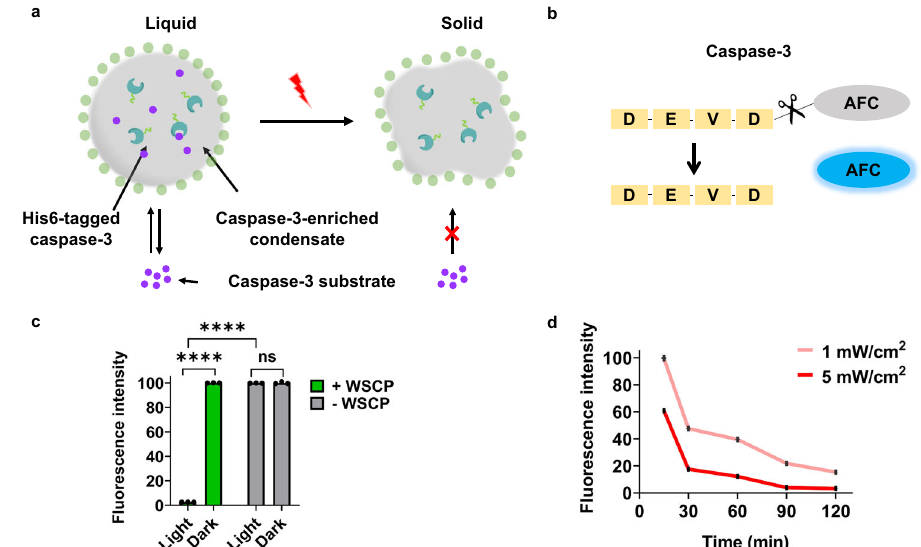
Fig. 7 Photo-controlled catalysis within RMR condensates. a Schematic illustration of the mechanism for controlling catalysis within the caspase-3-laden condensate via red-light-induced phase transition. Substrates readily diffuse into a liquid condensate, but not into a solid particle. b Schematic illustration of the fl uorogenic caspase-3 substrate, Z-DEVD-AFC. AFC, 7-amino-4-tri fl uoromethylcoumarin, with λ ex ¼ 405nmand λ em ¼ 500nm. c In fl uence of light and WSCP on bound caspase-3. Light intensity: 5 mW/cm 2 ; irradiation duration: 120 min. Data are presented as mean ± SD ( n = 3); two-side t -test, p -value: **** < 0.0001 ( p = 3.41 × 10 − 7 (Light + WSCP vs Light - WSCP)); p = 7.92 × 10 − 7 (Light + WSCP vs. Dark + WSCP). d In fl uence of irradiation duration and intensity on catalysis. Data are presented as mean ± SD ( n = 3).